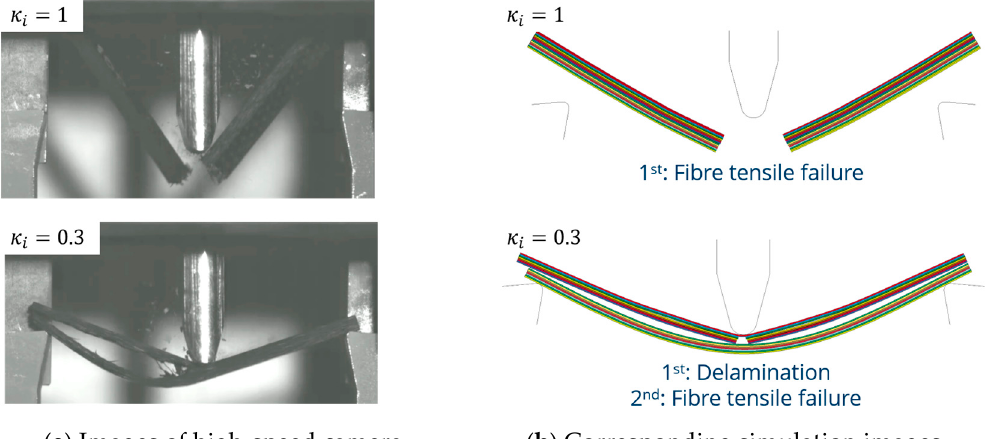
Figure 8. ( a ) Images of high-speed camera during the three-point bending test for two different interface modification concepts [10] and ( b ) corresponding simulation images.